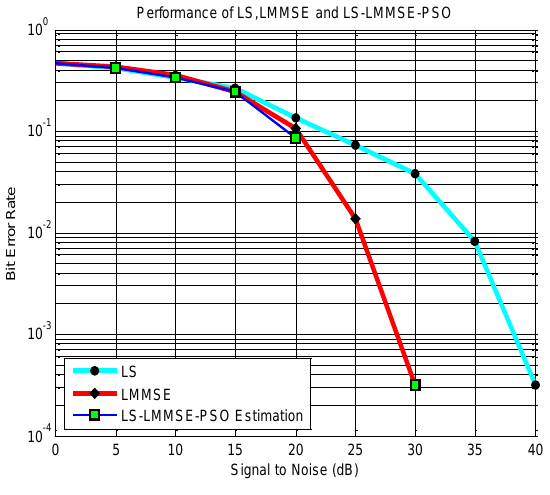
Figure 9: BER v/s SNR at Doppler frequency – 50 Hz